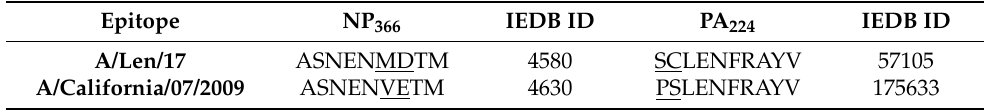
Table 4. Immunodominant epitopes for H-2 b haplotype mice NP 366 and PA 224 in A/Len/17 and A/California/07/2009 proteins.